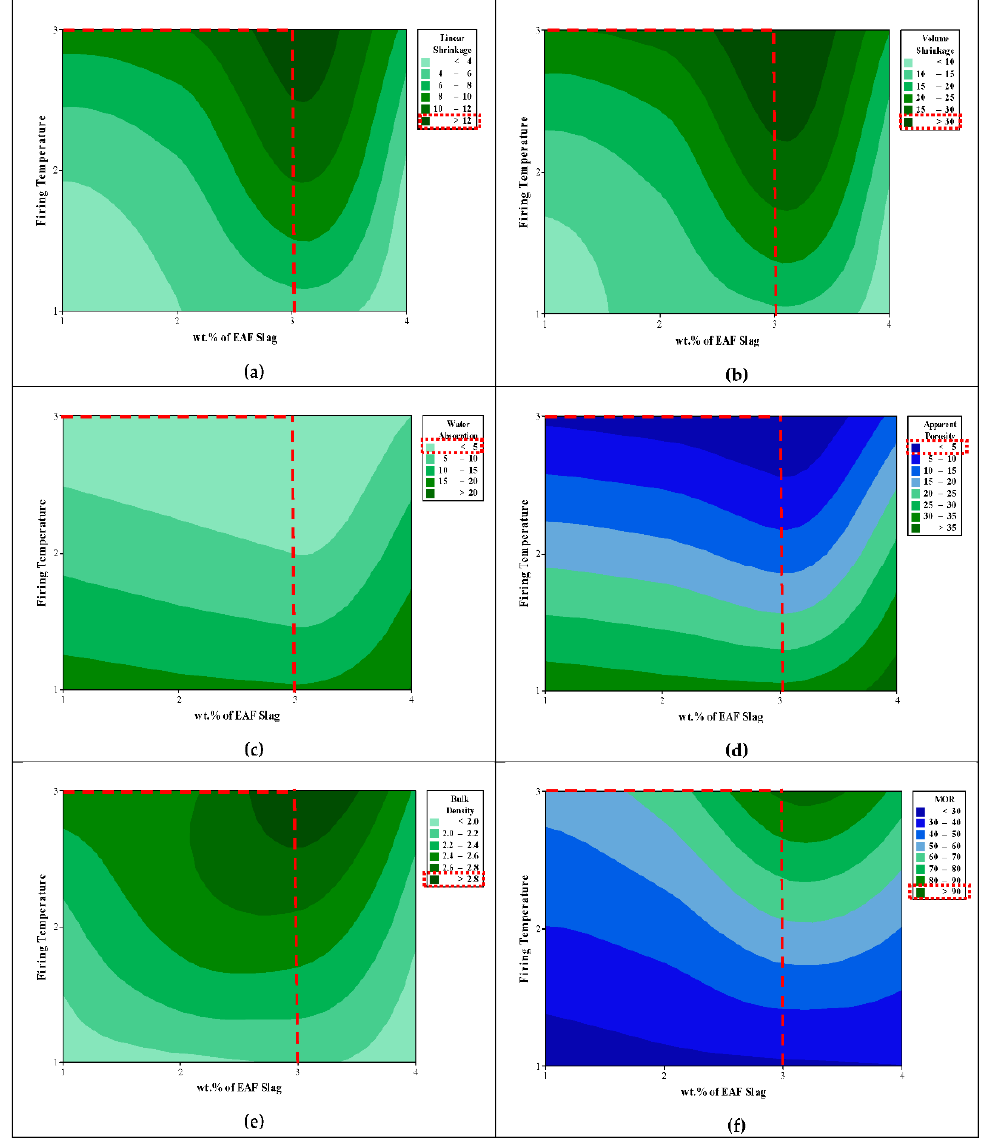
Figure 4. Contour plot of ( a ) linear shrinkage, ( b ) volume shrinkage, ( c ) water absorption, ( d ) water absorption, ( e ) bulk density, ( f ) MOR, and their correlations.